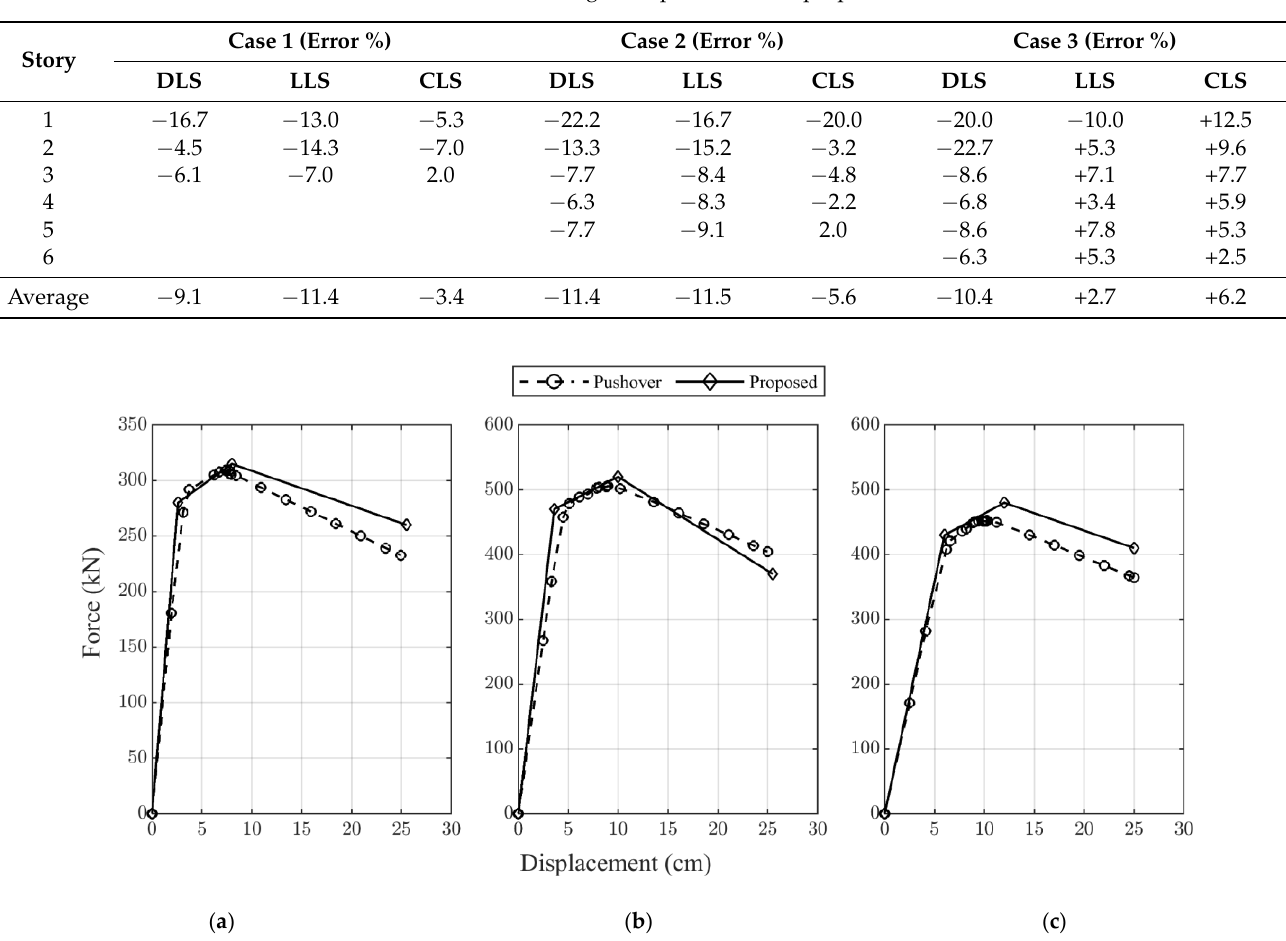
Figure 7. Comparison of the capacity curves from the full pushover analysis (dashed lines) and the proposed analytical method (thick lines): ( a ) Case 1 (3 storeys); ( b ) Case 2 (5 storeys); ( c ) Case 3 (6 storeys).